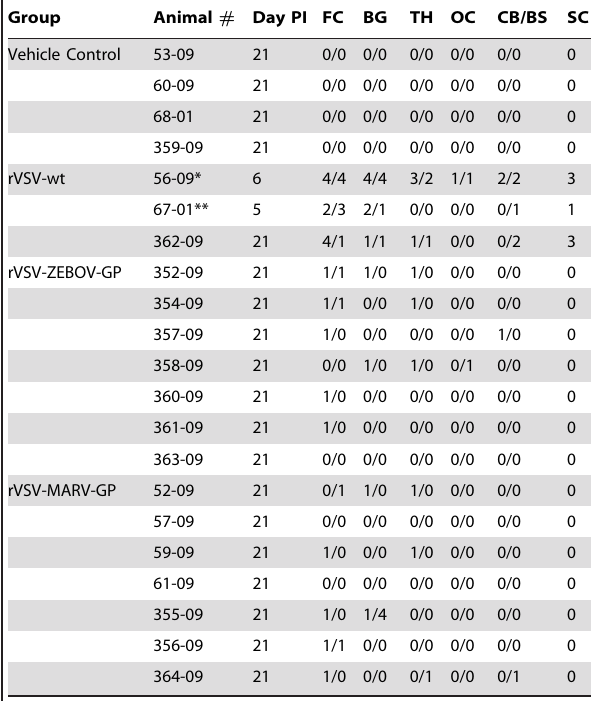
Table 4. Histopathological scores from left/right hemisphere of the brain and spinal